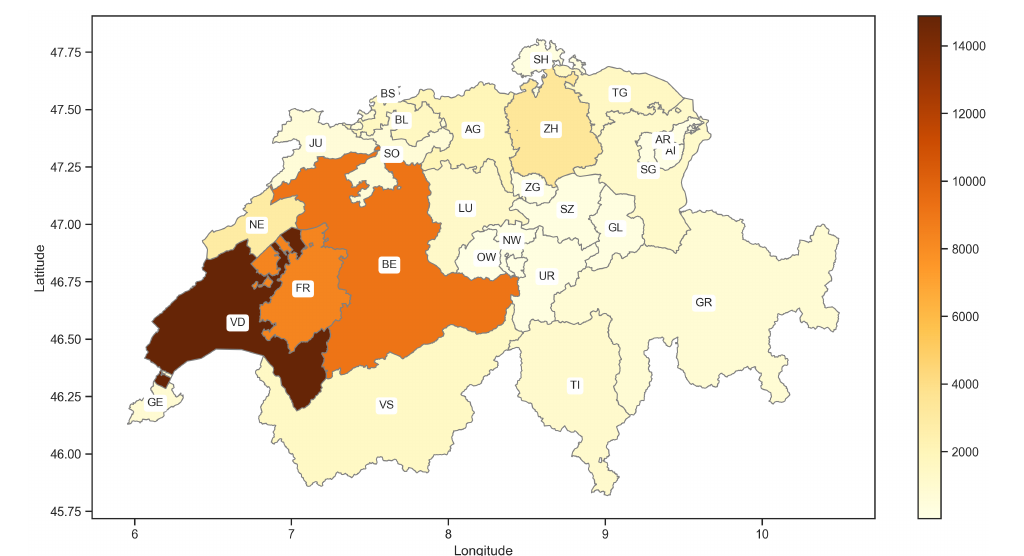
Figure 1. Map of Switzerland showing the concentration of building energy performance certificates (CECB) per cantons.